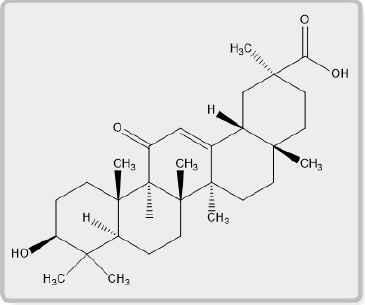
Figure 1. The chemical structure of 18 β -glycyrrhetinic acid. From licorice, two stereoisomers of glycyrrhetinic acid were isolated: 18 β GA and 18 α -glycyrrhetinic acid. Glycyrrhetinic acid is an oleanane-type triterpenoid with a car- boxylic acid instead of a methyl group at C-30. Furthermore, the quantity of 18 β GA in licorice root ranges from 0.1 to 1.6 percent, while 18 α -glycyrrhetinic acid is usually